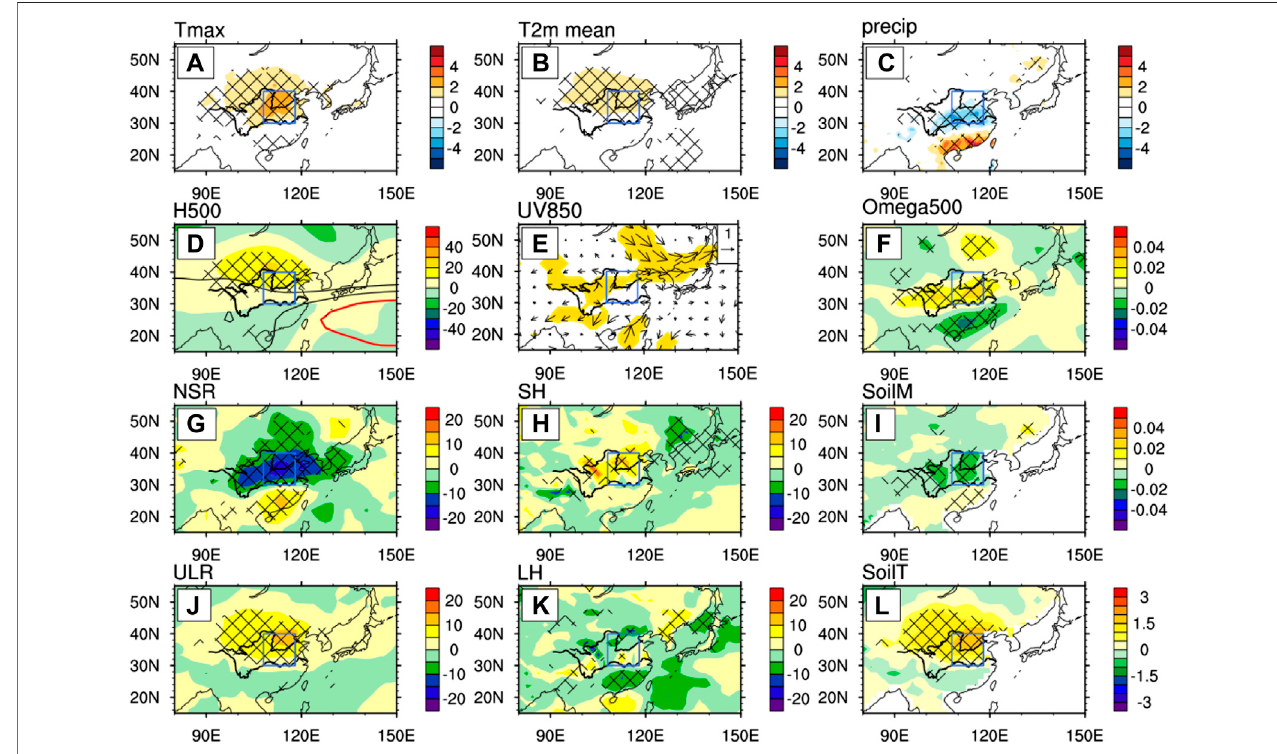
FIGURE 7 | Same as Figure 6 , but for